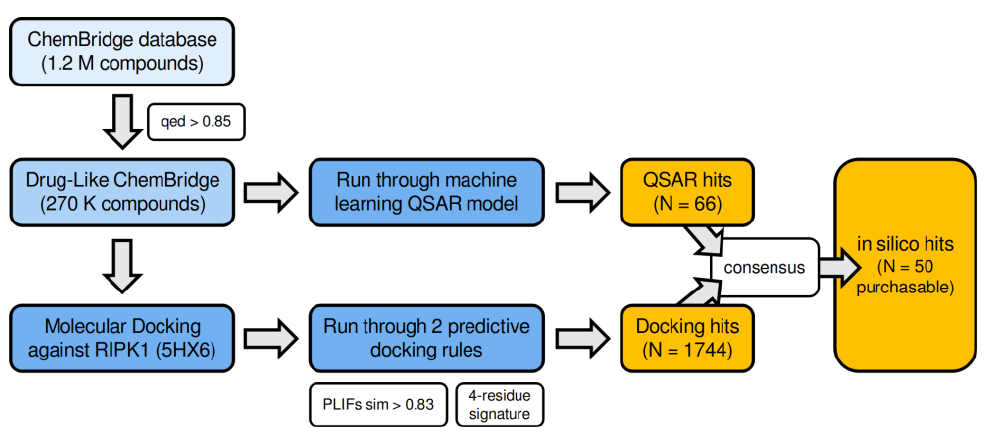
Figure 14. Summary of the screening workflow applied to the ChemBridge library of compounds to obtain the 50 in silico hits purchased for testing.